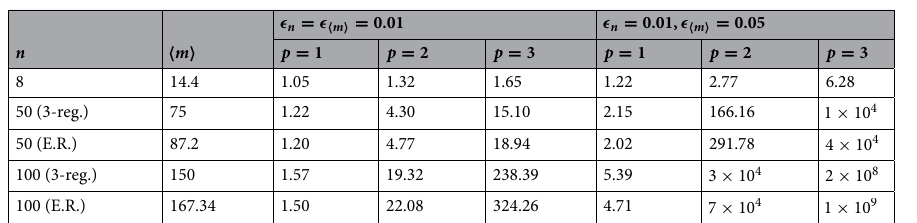
Table 4. The ratio of the expected number of measurements to obtain a sample from the noiseless distribution for p -QAOA relative to 1-ma-QAOA on an n vertex graph, assuming an average number of edges graphs in the datasets.